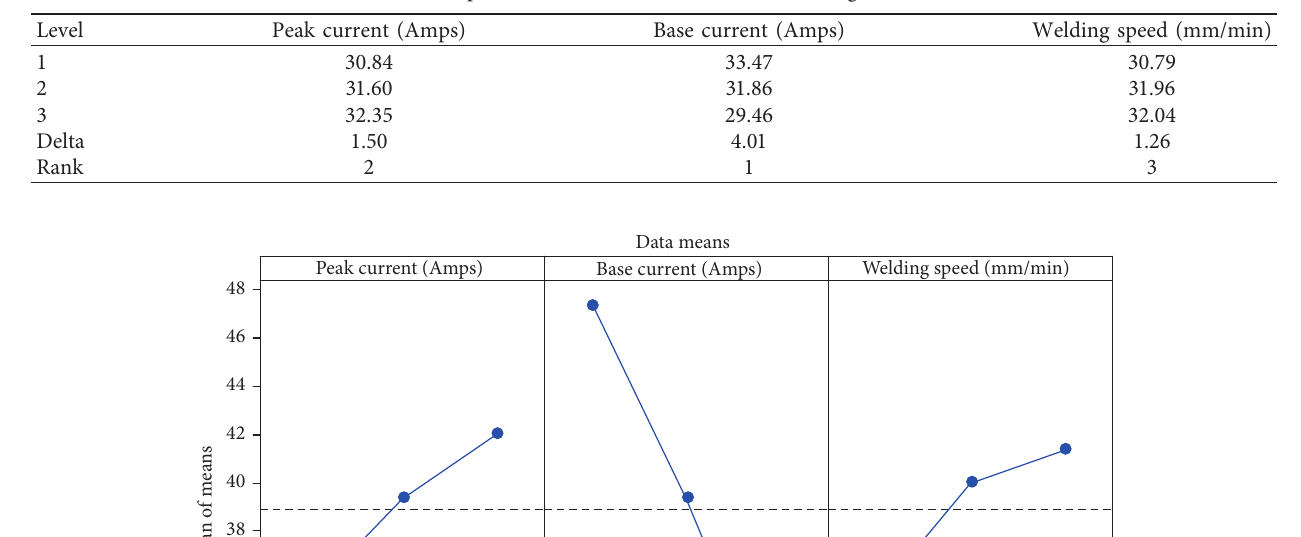
Table 15: Response table for S/N ratios (hardness) (larger is better).